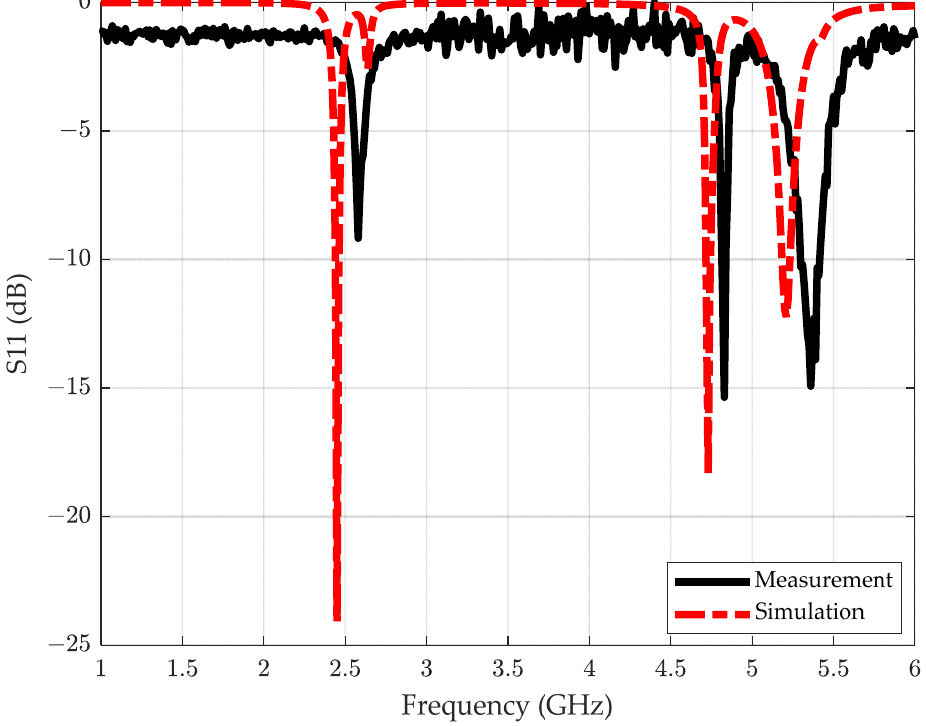
Figure 9. Comparison of |S11| plots of the simulation and the measurement.